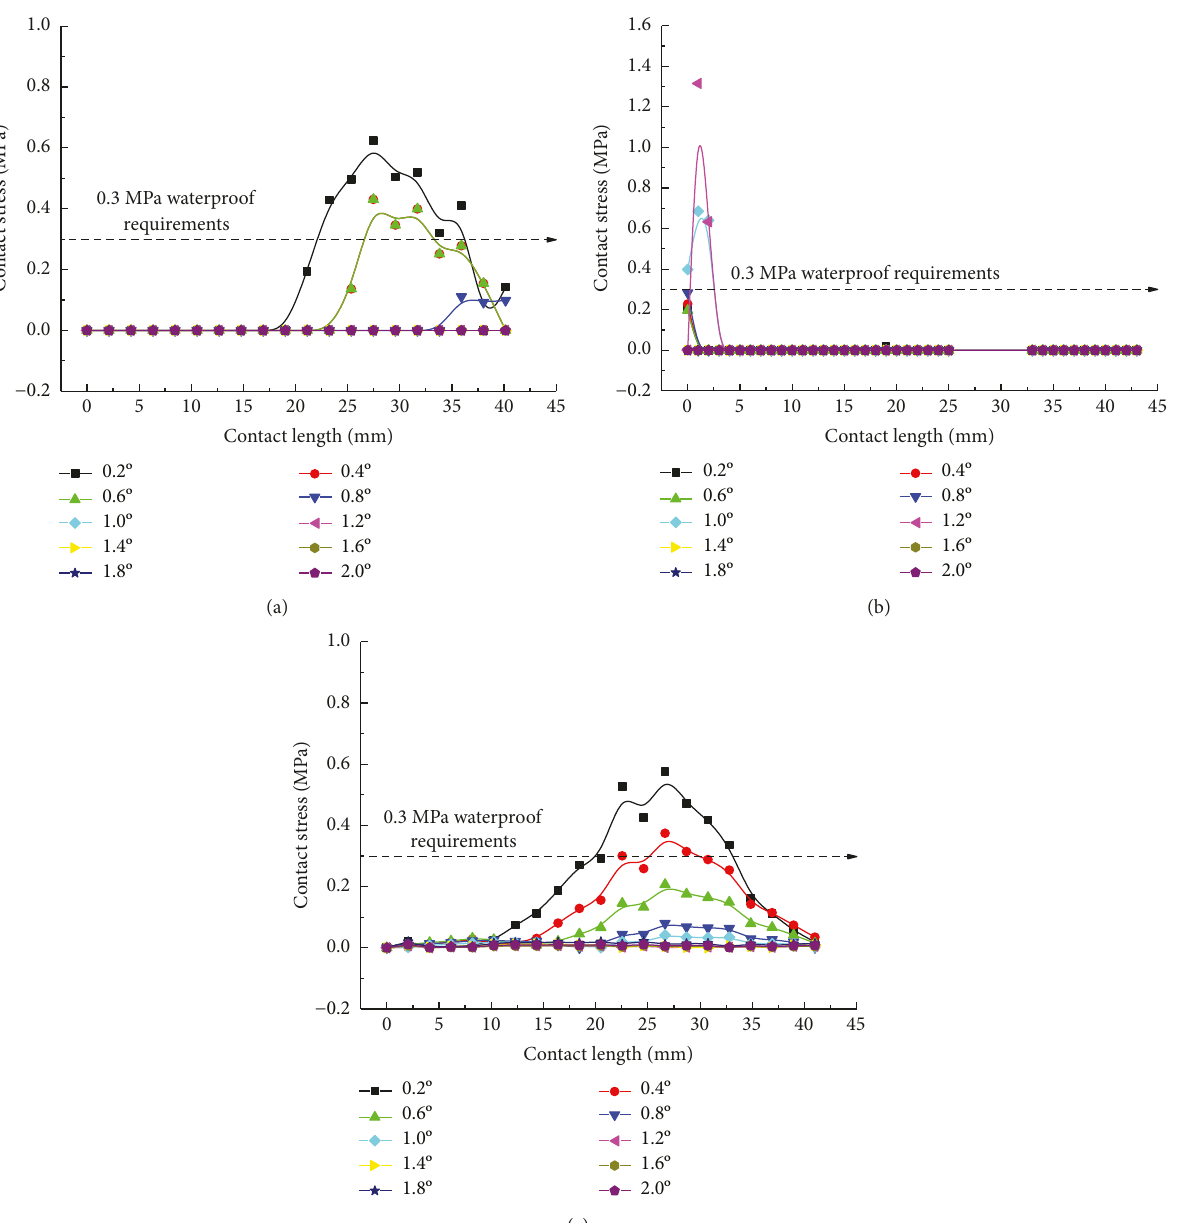
Figure 26: Contact stress curve of the second rubber ring after optimizing during anticlockwise rotation: (a) contact pressure of line 1 for the second rubber ring, (b) contact pressure of line 2 for the second rubber ring, and (c) contact pressure of line 3 for the second rubber